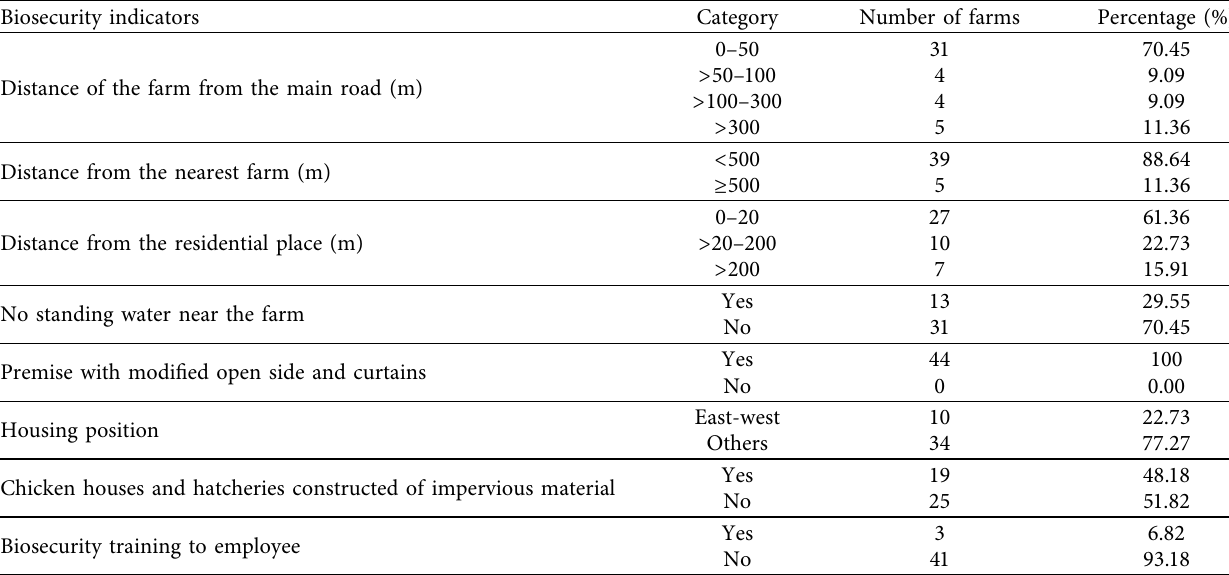
Table 3: The frequency and percentage of indicators of conceptual